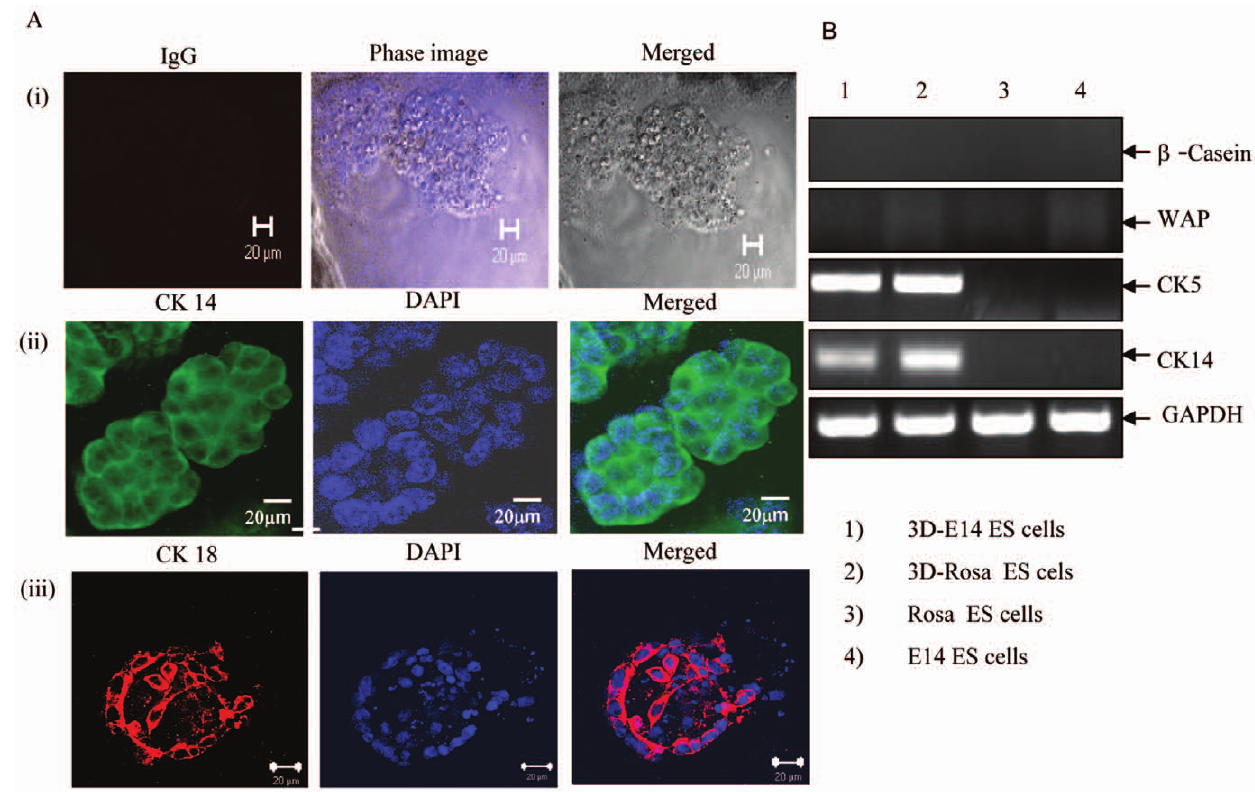
Figure 1. mES cells were able to clonally reproduce acini invitro. (A) Confocal microscopy of mES E14-GFP cells (Panels A(i) and A(ii) and Rosa 26.6 ES cells Panel A(iii) showing acini structures. The mES cells were grown in epithelial media under 3D Matrigel matrix conditions. Cells were grown for 10 days and stained with control IgG (Panel i) or with CK14 antibody (Panel ii), or with cytokeratin CK 18 (Panel iii). In addition, nuclear staining (DAPI) was performed, and is shown at 60X magnification (scale bar, 20 m m). This is a representative experiment out of four experiments. (B) RT-PCR analysis of 3-D mammary epithelial cell cultures derived from 3D-E14-ES cells (lane 1) 3D-Rosa 26.6 mES cells (lane2), control Rosa ES cells and E14-ES cells, respectively (lanes 3 and 4). Specific primers for murine b -casein, WAP, CK 5, CK 14 and GAPDH were used in this analysis. This is a representative experiment out of 3.